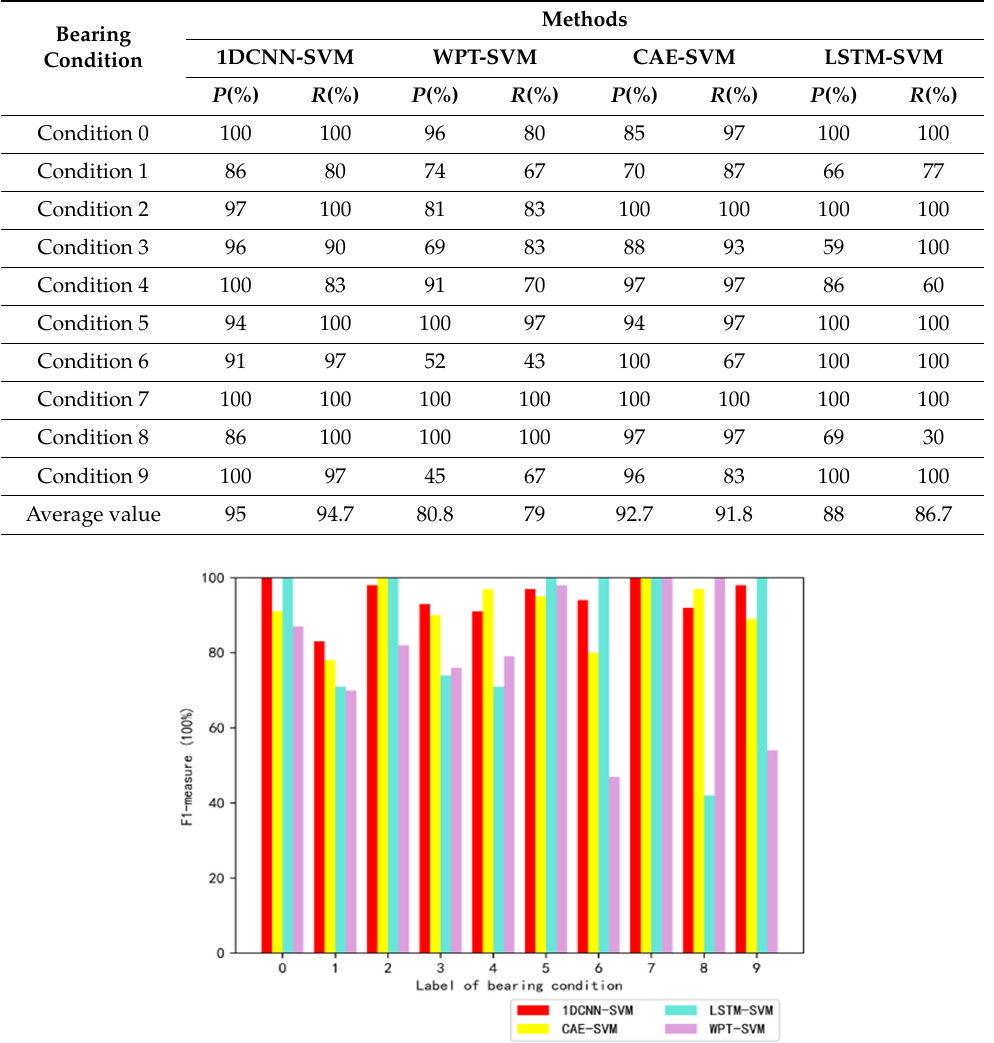
Table 4. The precision rate and recall rate of different methods.